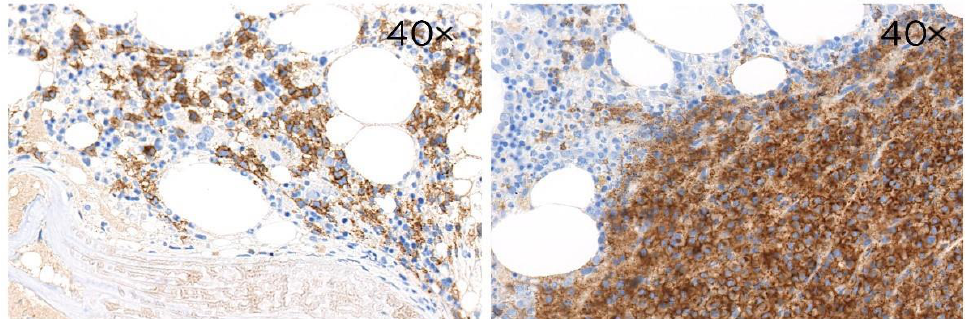
Figure 5. Architectural patterns of bone marrow infiltration by plasma cells by CD229 immunohistochemical stain. Single immunoperoxidase labeling in myeloma with mAb (clone PIZCU426) against CD229. All the pictures are at 40× magnification.